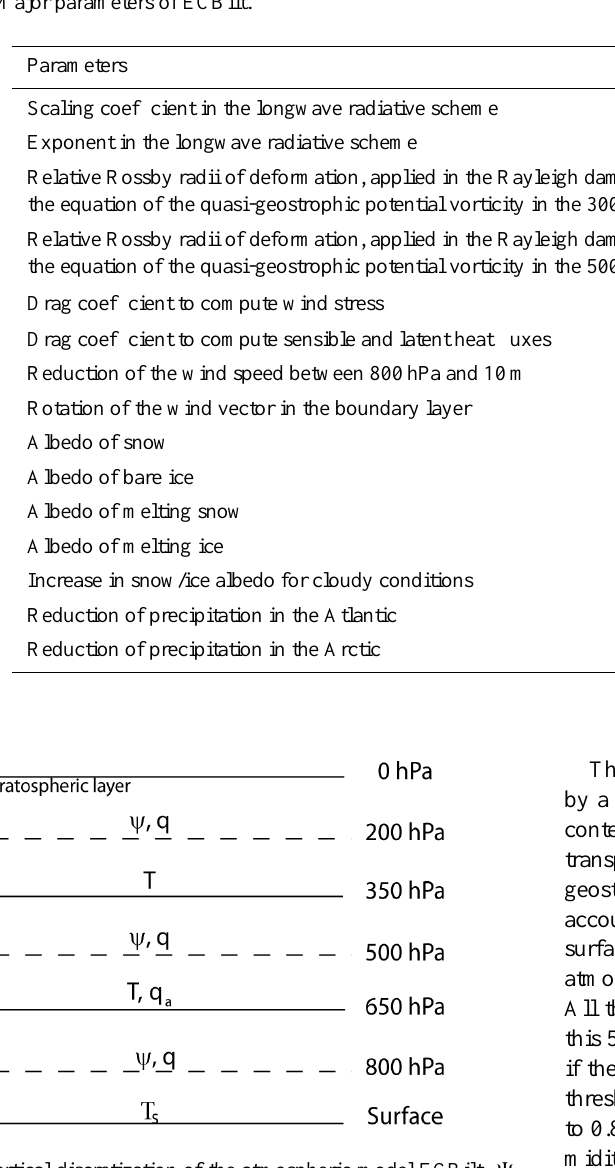
Table 1. Major parameters of ECBilt.